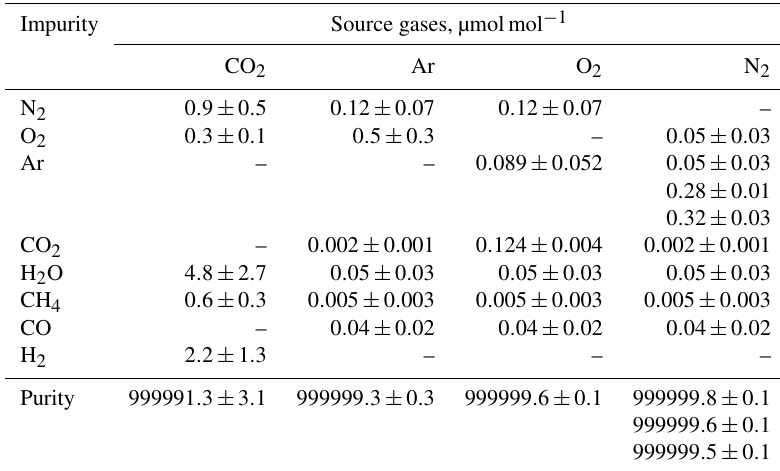
Table 4. Impurities in source gases for preparation of